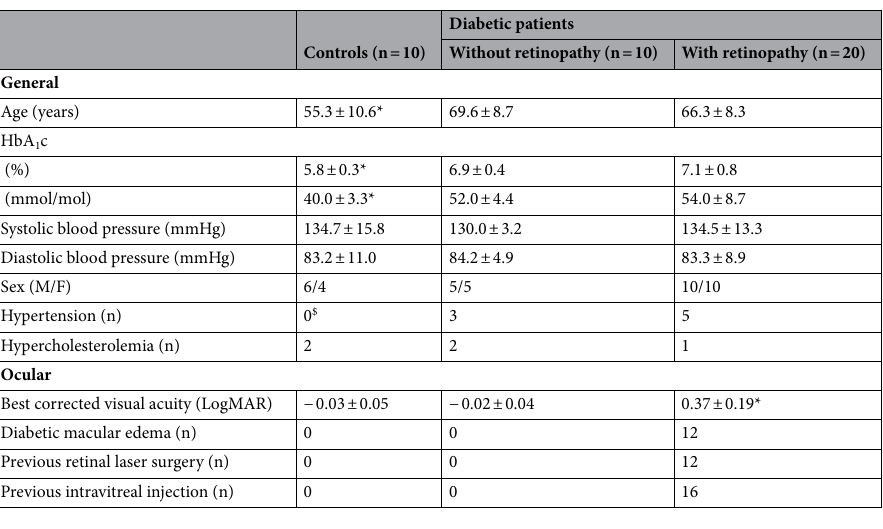
Table 1. Study population. Continuous variables are reported as mean ± standard deviation; *p < 0.01 for comparison with other groups by ANOVA with Bonferroni post-hoc test. $ p < 0.05 for comparison with other groups by Pearson χ 2 . No other statistically significant differences